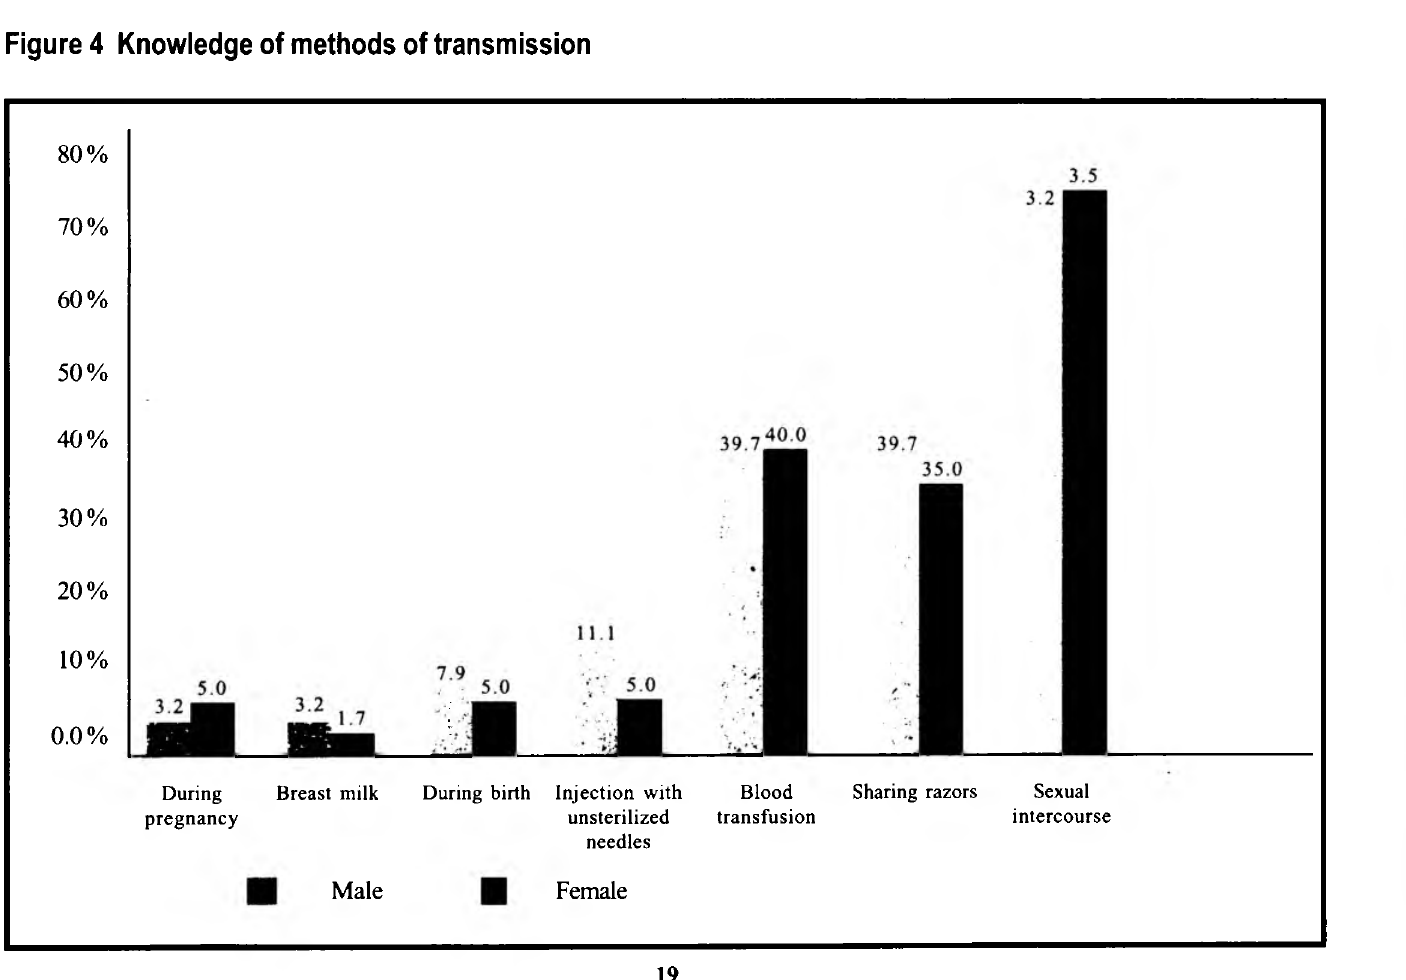
Figure 4 Knowledge of methods of